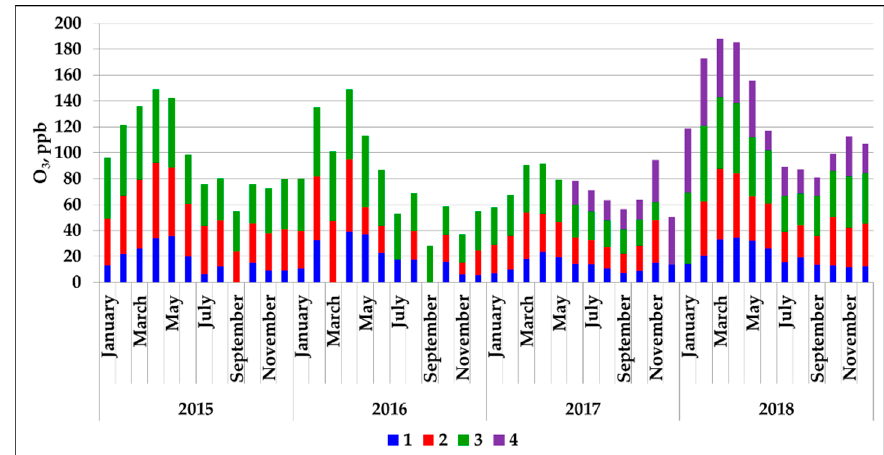
Figure 2. Inter-annual ozone concentration dynamics at the Irkutsk (1), Listvyanka (2), Mondy (3) and Bugul’deyka (4) monitoring sites sampled by the passive sampling method, 2015 – 2018.